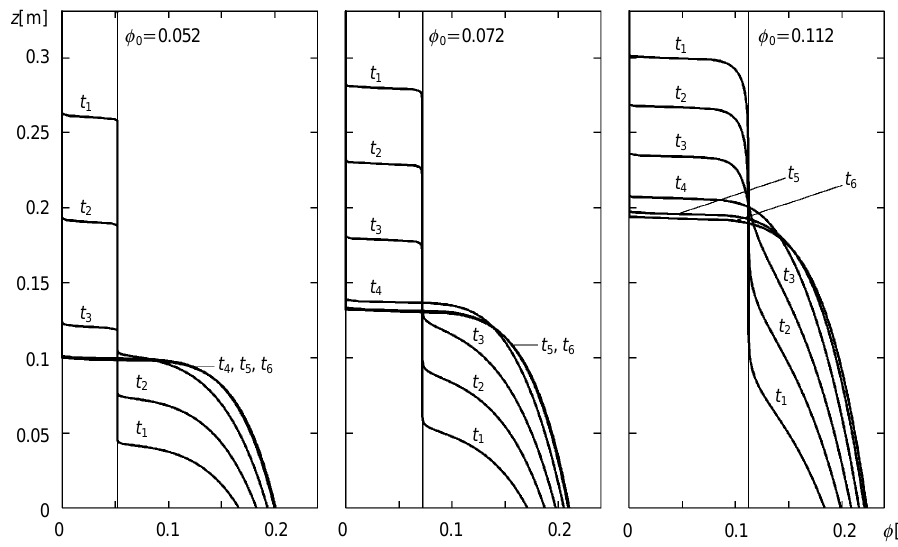
Simulation of batch sedimentation of a talc suspension in a column (Bürger and Karlsen 2001, Garrido et al. 2000, Holdich and Butt 1997): concentration profiles at different times for three different initial concentrations.